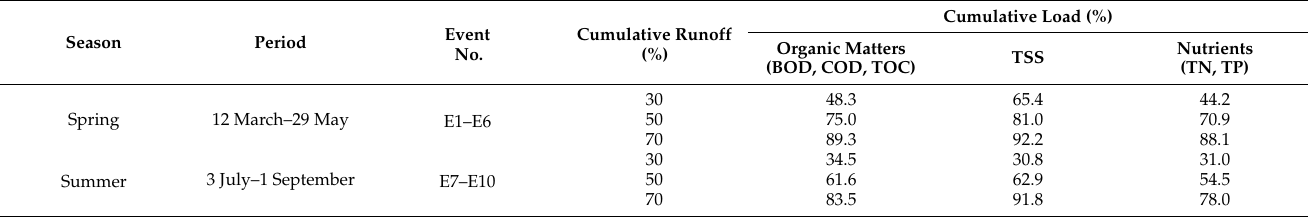
Table 2. Average cumulative load relative to cumulative runoff in spring and summer in the immedi- ate post-fire period.